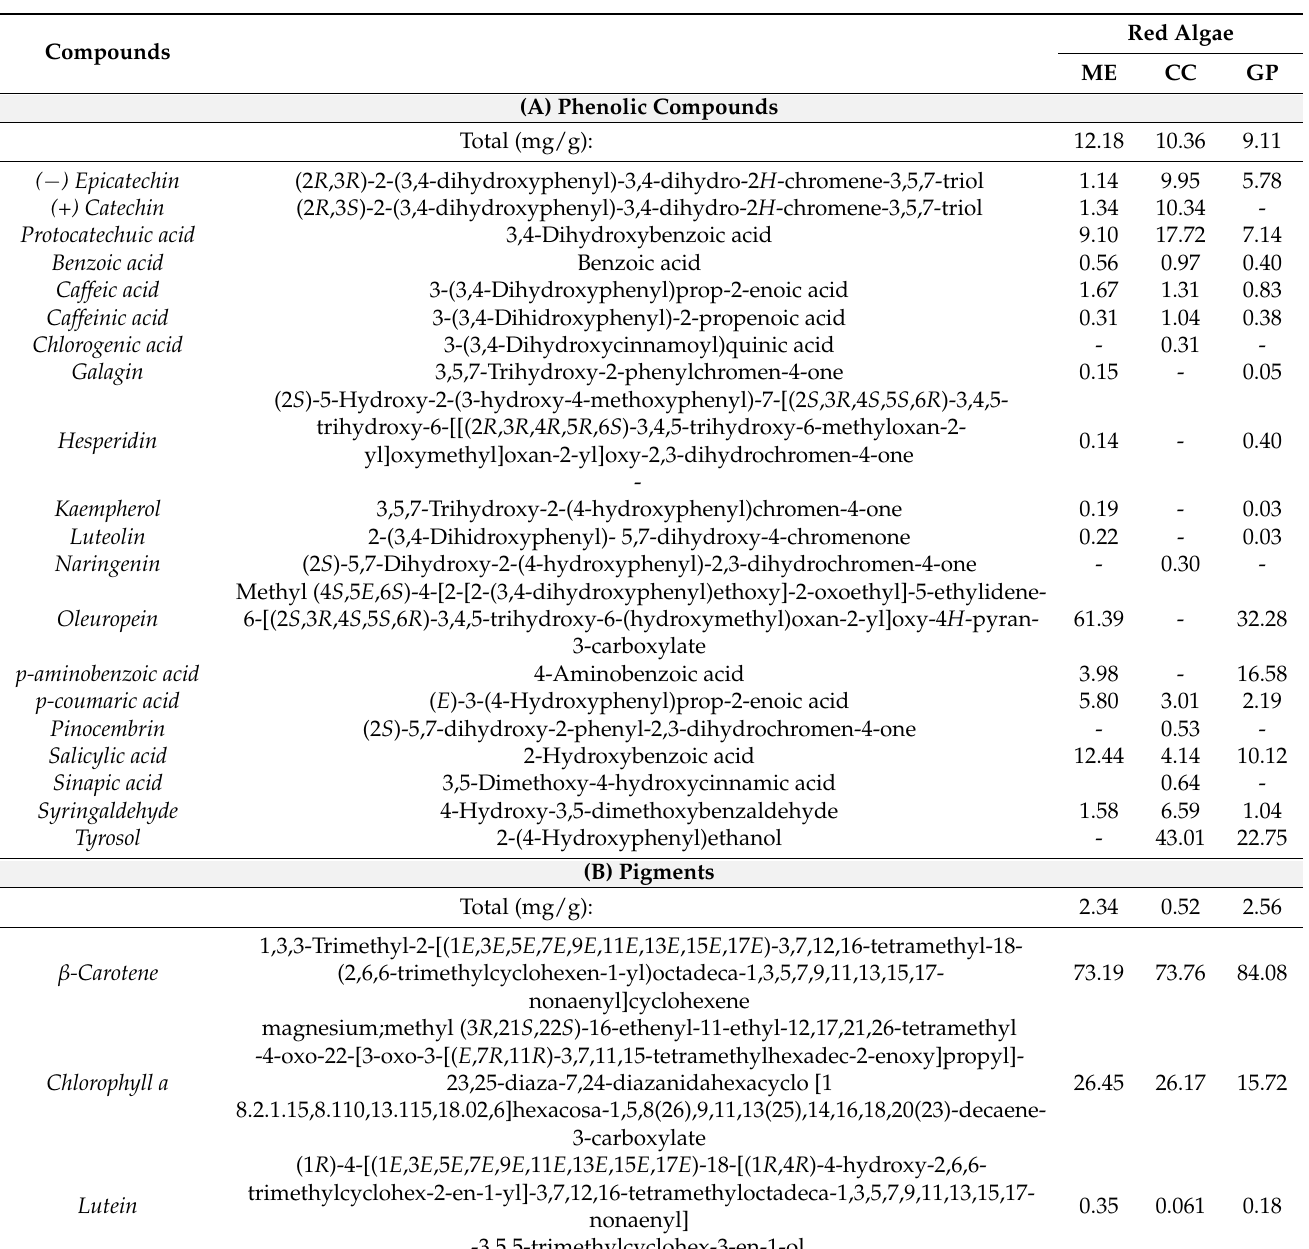
Table 7. Total content (mg/g) and individual content (in % of abundance) of phenolic compounds and pigments in the marine